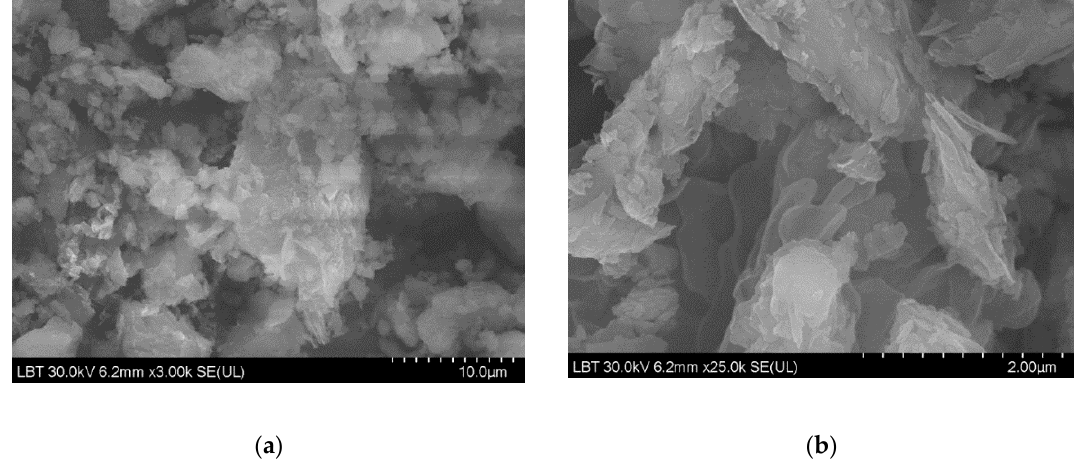
Figure 1. SEM images of the NZ 200 with a smaller particle size (<0.5 mm), at two different resolutions: 10 µm ( a ) and 2 µm ( b )